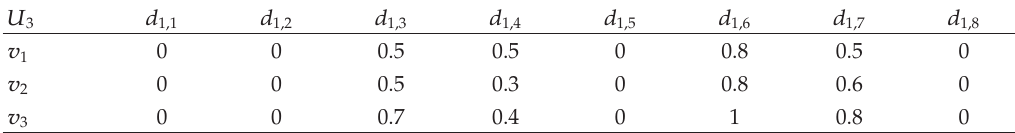
Table 8: Comparison table: U (cid:5) H,D (cid:6) . 3 -fuzzy soft multiset part of of 2 U v v v 3 1 2 3 v 1 8 7 5 v 2 7 8 4 v 3 7 8 8